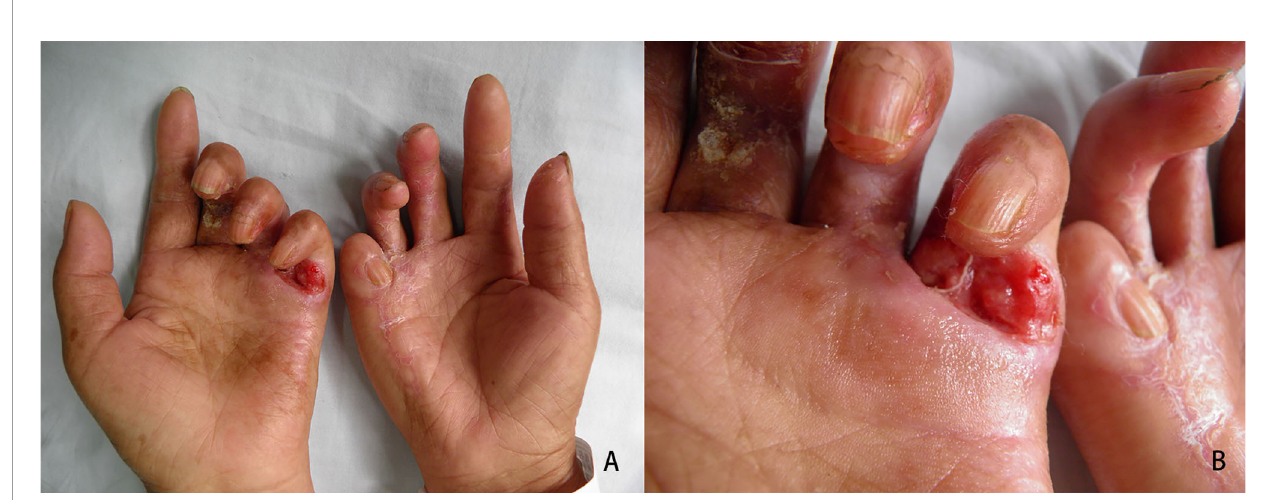
FIGURE 1 | Clinical features of the hand lesions. (A, B) Contracture deformity of both hands was evident, and an ulcer was detected on the fl exor side of the 5th metacarpophalangeal joint of the left